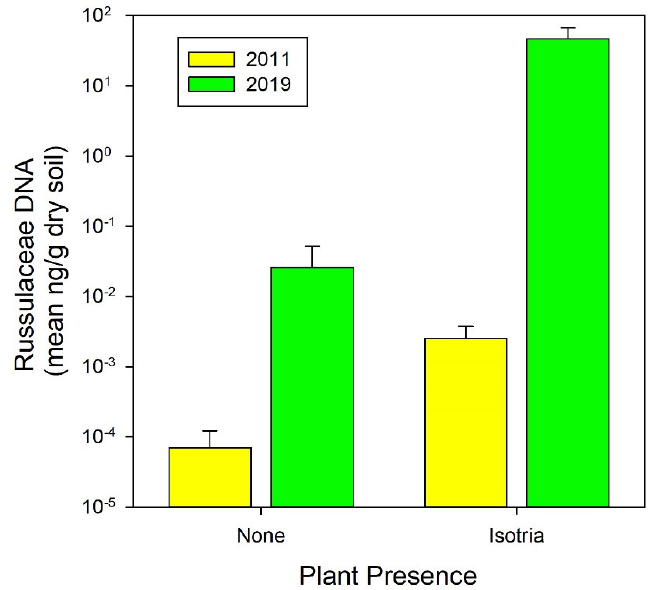
Figure 8. Concentration of Russulaceae DNA in soil samples collected in the “natural experiment” population, where a tree died and fell, in areas where no plants occurred (left bars) and areas where plants emerged (right bars) in 2011 (yellow bars, data from [29]) and 2019 (green bars). Note the log scale on the y ‐ axis.